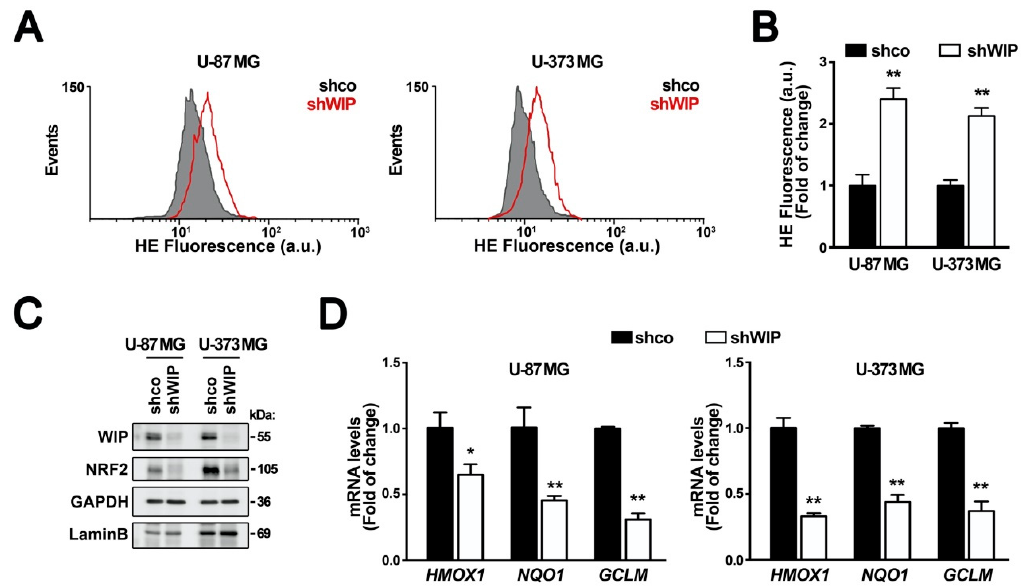
Figure 1. WIP knocked-down cells exhibit increased evels of reactive oxygen species (ROS) and decreased NRF2. U-87 MG and U-373 MG glioblastoma cells were transduced with lentiviral vectors containing shcontrol (shco) or human shWIP. ( A ) Changes in intracellular ROS were determined by HE staining (a.u., arbitrary units of fluorescence emission) ( n = 3). ( B ) Flow cytometry analysis of shNRF2-induced intracellular ROS production in HE stained cells (a.u., arbitrary units of fluorescence emission). A representative sample of 10,000 cells is shown for each condition. Data are presented as mean ± S.D. ** p ≤ 0.01 according to a Student’s t -test. ( C ) Representative immunoblots of WIP, NRF2, GAPDH, and LaminB as loading controls ( n = 3). ( D ) Messenger RNA (mRNA) levels of HMOX1 , NQO1 , GCLM were determined by qRT-PCR and normalized by the geometric mean of GAPDH and TBP . Data are presented as mean ± S.D. ( n = 3) * p ≤ 0.05, ** p ≤ 0.01 according to a Student’s t -test.